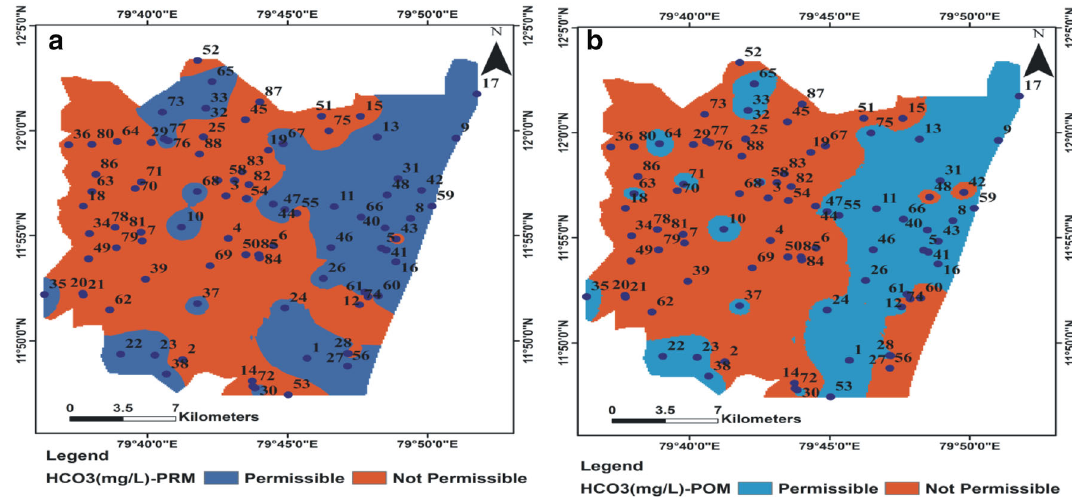
Fig. 12 a , b Spatial distribution map of HCO 3 (pre- and Table 5 Classification of groundwater based on SAR (Todd 1980; Richards 1954) SAR Suitability Number of samples for irrigation percentage pre-